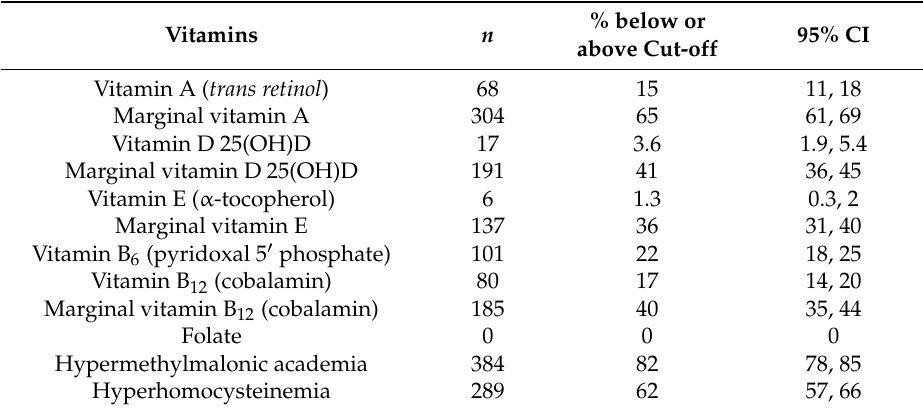
Table 4. Prevalence of vitamin (A, D, E, B 6 , B 12 , folate) deficiencies and metabolic markers (MMA and tHcy) in healthy infants of Bhaktapur, Nepal ( n = 467).